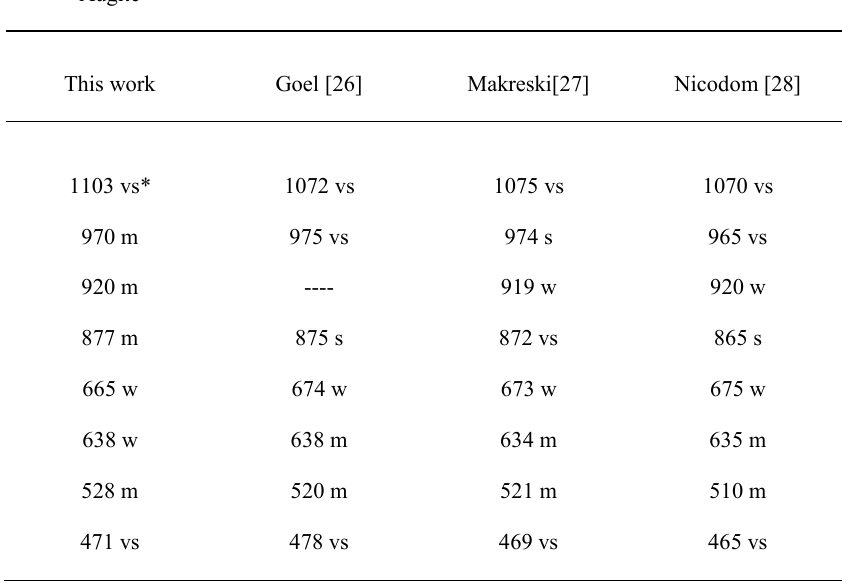
Table 5. The bands in FTIR spectrum of Augite compared to corresponding literature data. Augite